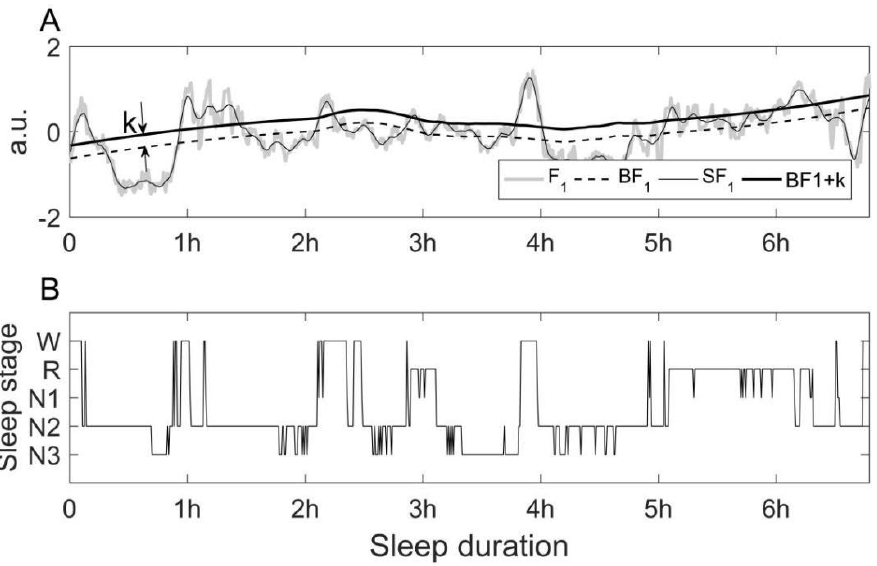
Figure 2. An example showing how to recognize wakefulness by the first principal component. ( A ) Variations of the first principal component for recognizing wakefulness segments. ( B ) Sleep stages. (F 1 is the first principal component. SF 1 and BF 1 are the smoothed result of F 1 at a small and a large frame length respectively. k is the translation range of BF 1 . The parts that meet SF 1 ＞ BF 1 +k are the recognized wakefulness segments.).